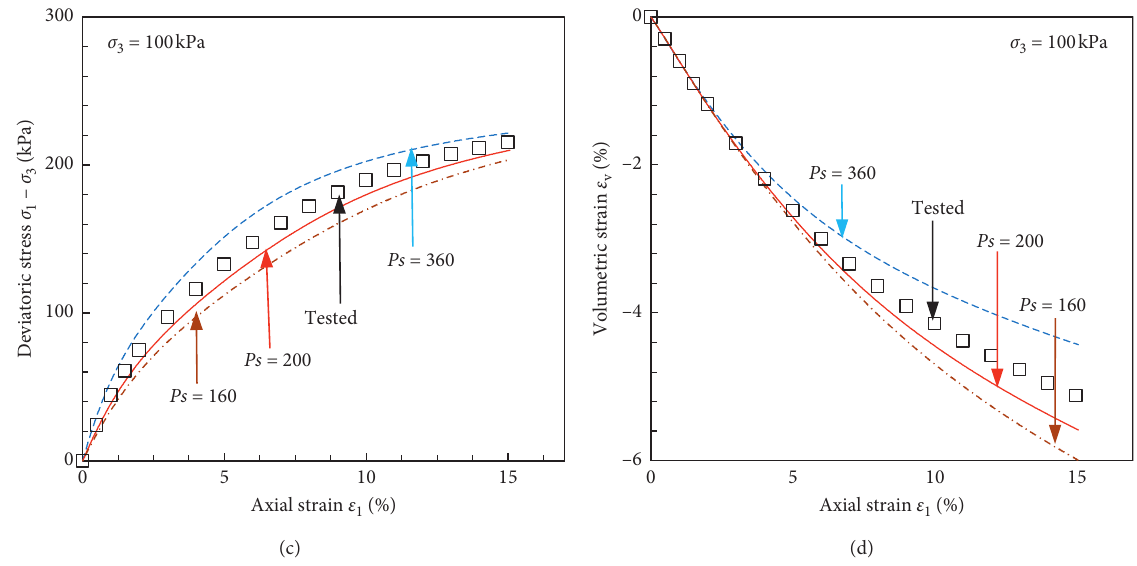
Figure 14: Effects of M and Ps on the stress-strain curves and volumetric strain-axial strain curves. (a) M -stress-strain curves. (b) M - volumetric strain-axial strain curves. (c) P s-stress-strain curves. (d) P s-volumetric strain-axial strain